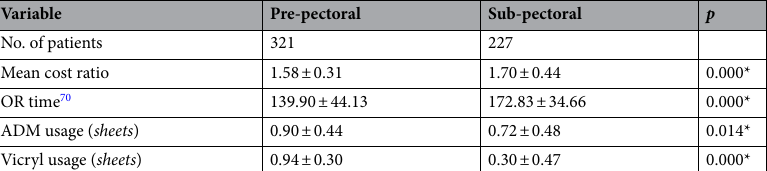
Table 5. Overall cohort mean cost comparison. This table describes the mean cost comparison of the sub- pectoral and pre-pectoral cohorts as a whole group. The pre-pectoral group was found to utilize significantly more ADM and Vicryl mesh while having lower operative time. The sub-pectoral approach to breast reconstruction was found to be more costly. Continuous variables were analyzed via independent two-tailed t-tests (95% confidence interval) and displayed with standard deviation values. ± SD; 95% CI. Cost ratio: a given cost value divided by the base procedural cost of unilateral direct-to-implant reconstruction. Values for ADM (acellular dermal matrix) or Vicryl mesh are averages across all patients in each group (e.g., 0.90 sheets of ADM used per patient in the pre-pectoral cohort). Operating room (OR) time is measured as procedure start to end time in minutes. *Statistically significant ( p <